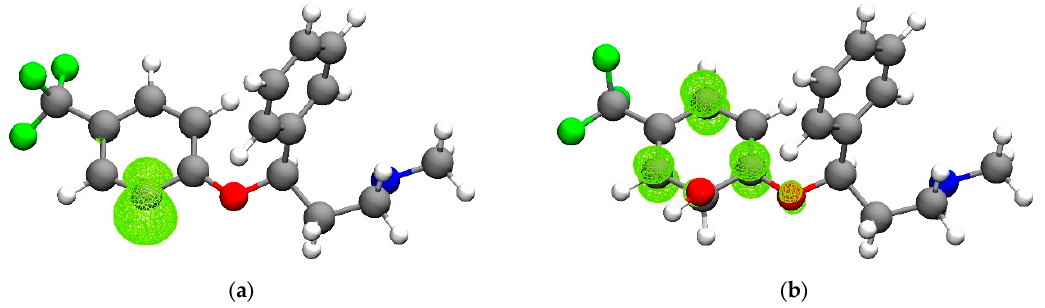
Figure 6. Spin densities on (1-H) • when HAT occurs from C1 ( a ) (1OH) • when RAF occurs at C1 ( b ). Level of theory: (SMD)-M06-2X/6-311+G(d,p)//M06-2X/6-31G(d). Level of theory: (SMD)-M06-2X / 6-311 + G(d,p) // M06-2X /